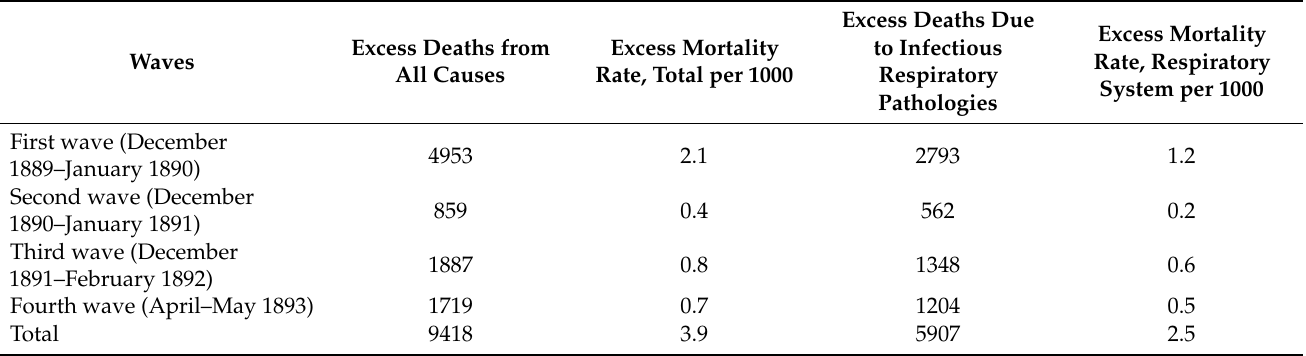
Table 1. Excess mortality from all causes and from respiratory pathologies in Paris between 1889 and 1893. Source: “Annuaire statistique de la ville de Paris”